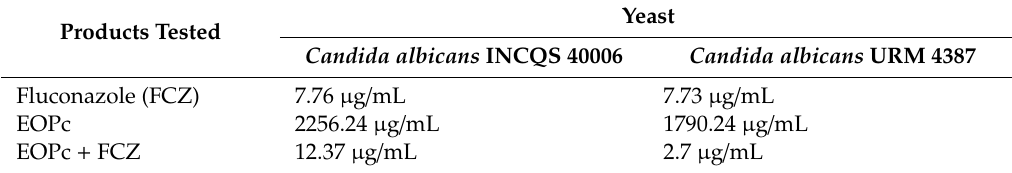
Table 2. IC 50 of the essential oil of Piper caldense (EOPc) against Candida albicans . Products Tested